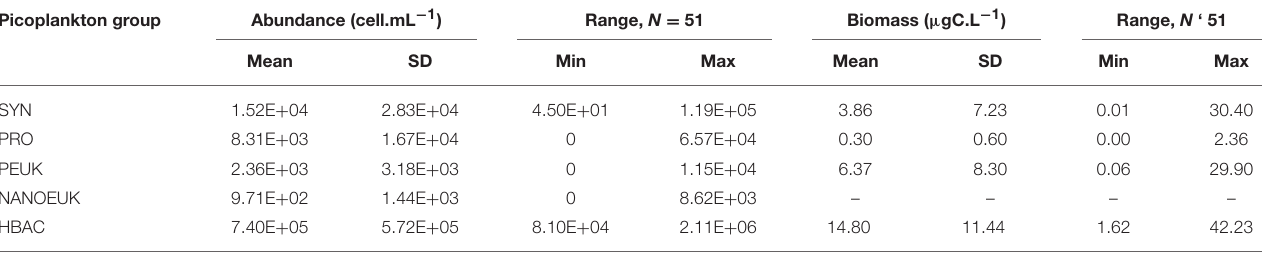
TABLE 2 | Means, standard deviations ( SD ) and minimum–maximum (min–max) range of picoplankton abundances (cell.mL − 1 ) and carbon biomass ( µ gC.L − 1 ) from all stations and depths. Picoplankton group